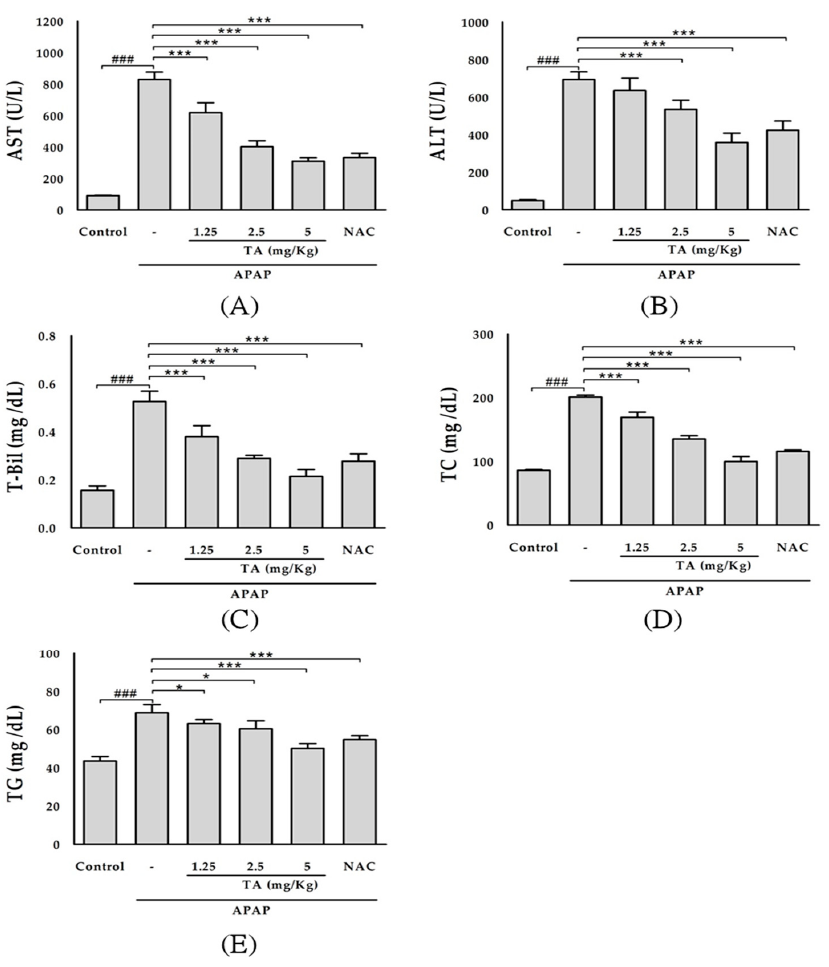
Figure 2. Effects of tormentic acid on serum AST ( A ); ALT ( B ); T-Bil ( C ); TC ( D ); and TG ( E ) in APAP-induced mice. The values are reported as the means ± S.E.M. of five mice per group. ### p < 0.01 compared with the control group; * p < 0.05, and *** p < 0.001 compared with the APAP group.